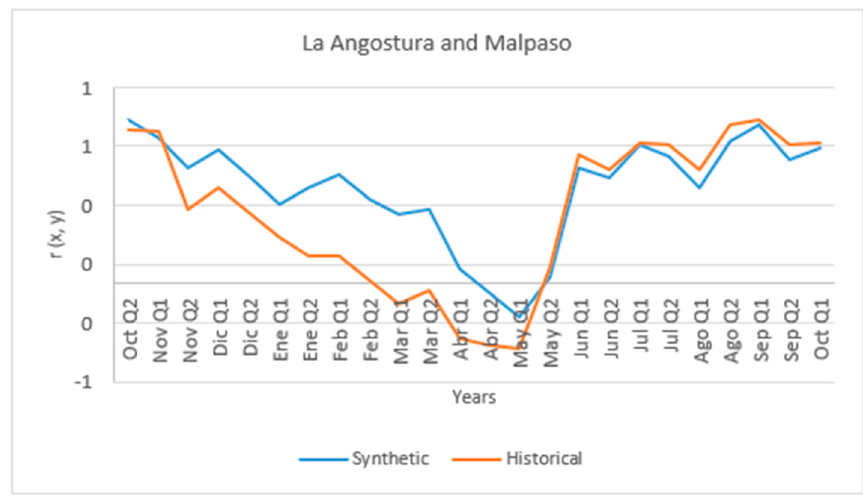
Figure 8. Comparison of the cross-correlation coefficient (rxy) of the 10 synthetic series of La Angostura and Malpaso dams. Table 5. Summary of the joint simulation of La Angostura and Malpaso dams. Energy generated per fortnight.